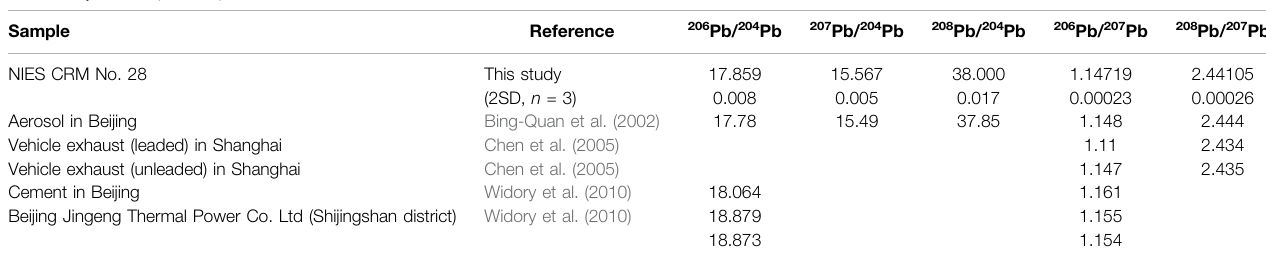
TABLE 6 | Pb isotopic compositions for aerosols.